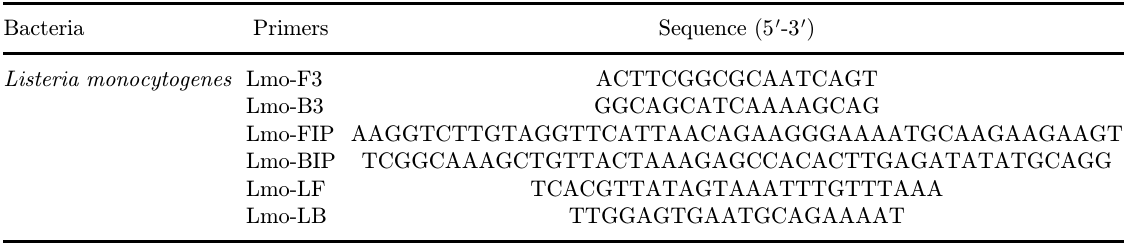
Table 1. Sequences of primer sets for Listeria monocytogenes identi¯cation. Bacteria Listeria monocytogenes